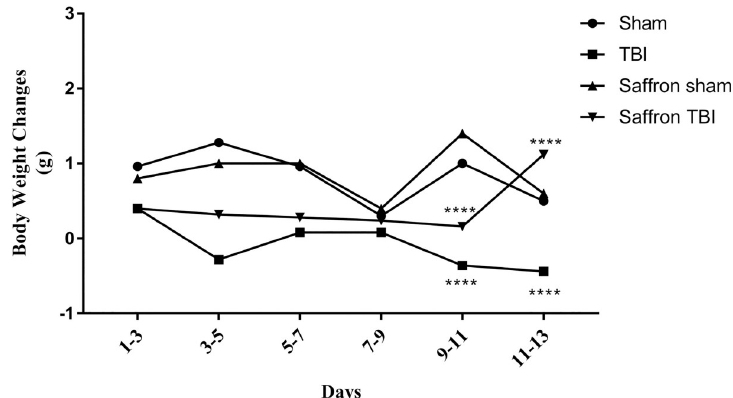
Fig 2. The weight change between day 0 and day 13. Sham, saffron sham, and saffron TBI mice were able to gain weight normally. TBI group failed to maintain normal body weights and start to lose weight significantly after Day 9. Data are mean ± SEM of 9 mice per group. ( ���� ) represent P <